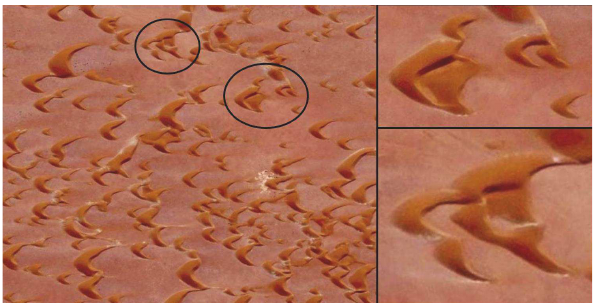
Fig. 4. (Color online) Collisions between barchan dunes are ubiq- uitous in this Moroccan dune field. On the right side two examples are